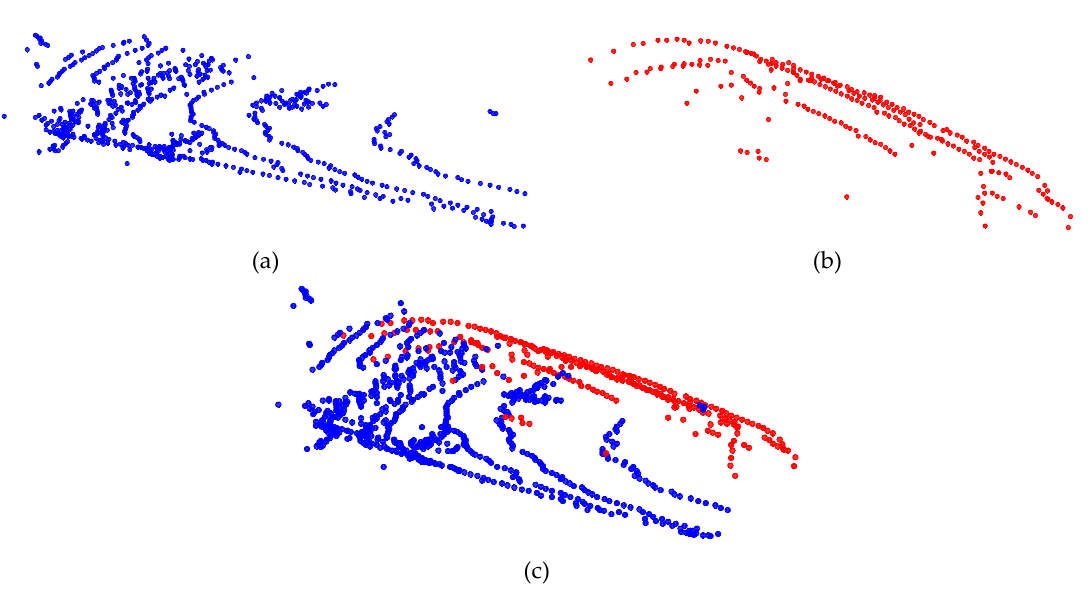
Figure 10. Before-and-after data integration. ( a ) Vehicle in Sensor A. ( b ) Vehicle in Sensor B. ( c ) Integrated vehicle.